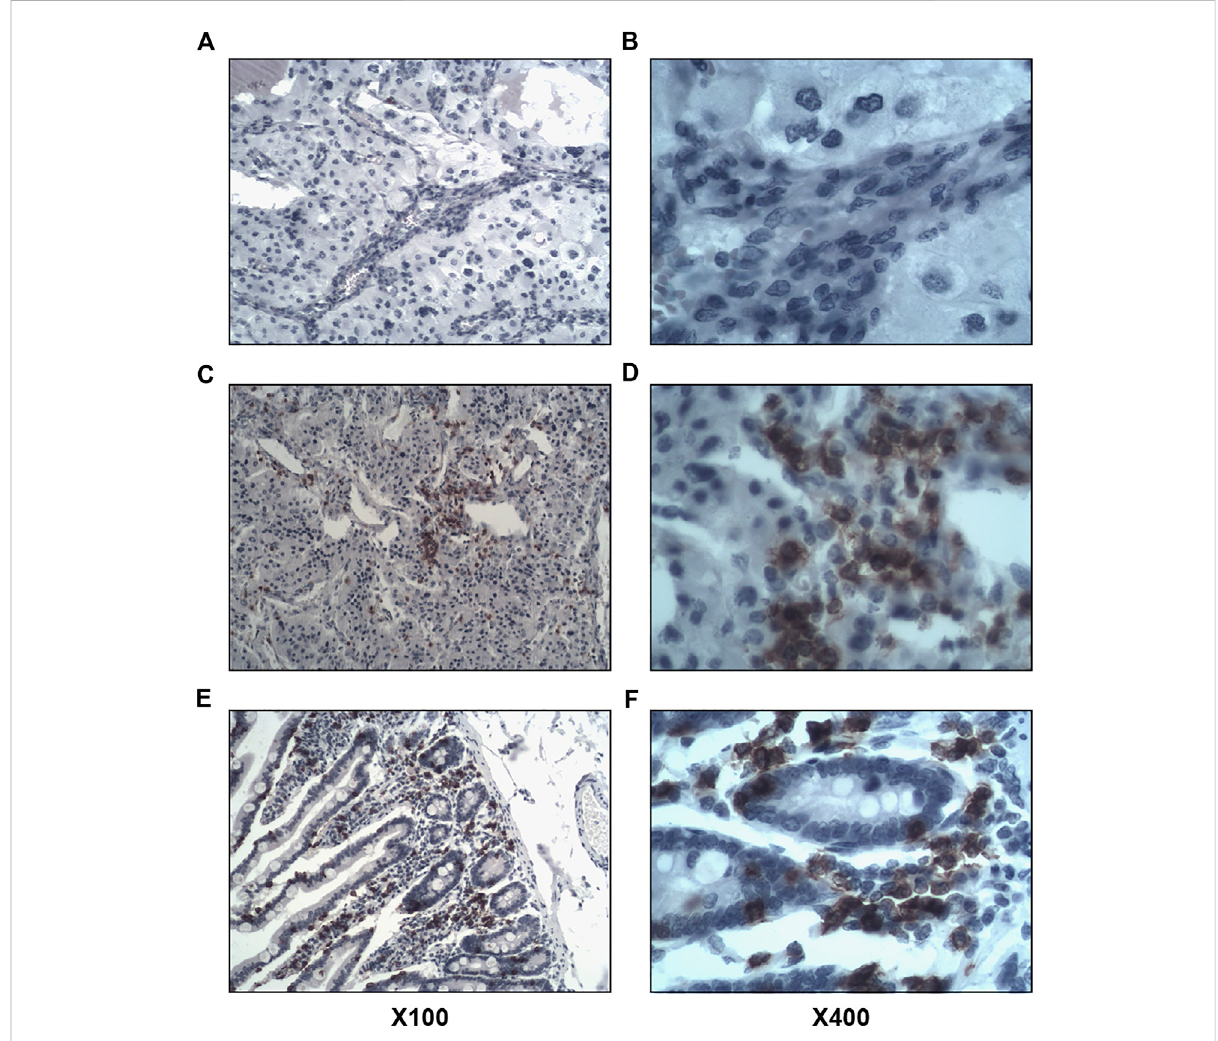
FIGURE 3 Immunohistochemical staining of CD8 + lymphocyte in fi ltration in tumor tissues. Left image × 100, right image × 400. (A,B) , negative for intratumoral and stromal CD8 + lymphocyte in fi ltration. (C,D) , positive for intratumoral CD8 + lymphocyte in fi ltration. (E,F) , positive for stromal CD8 + lymphocyte in fi